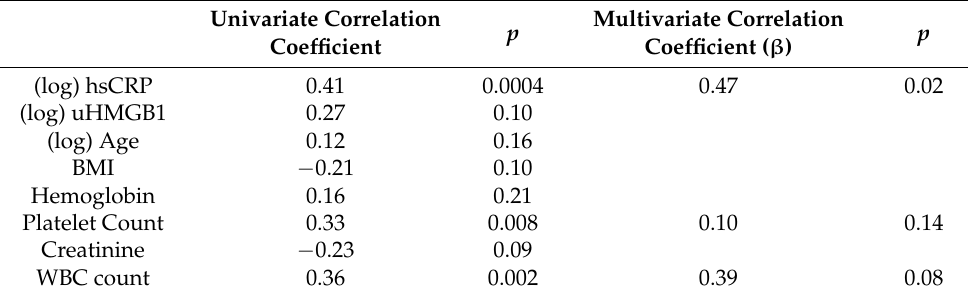
Table 2. Univariate and multiple regression analysis of (log-transformed) sHMGB1 levels.